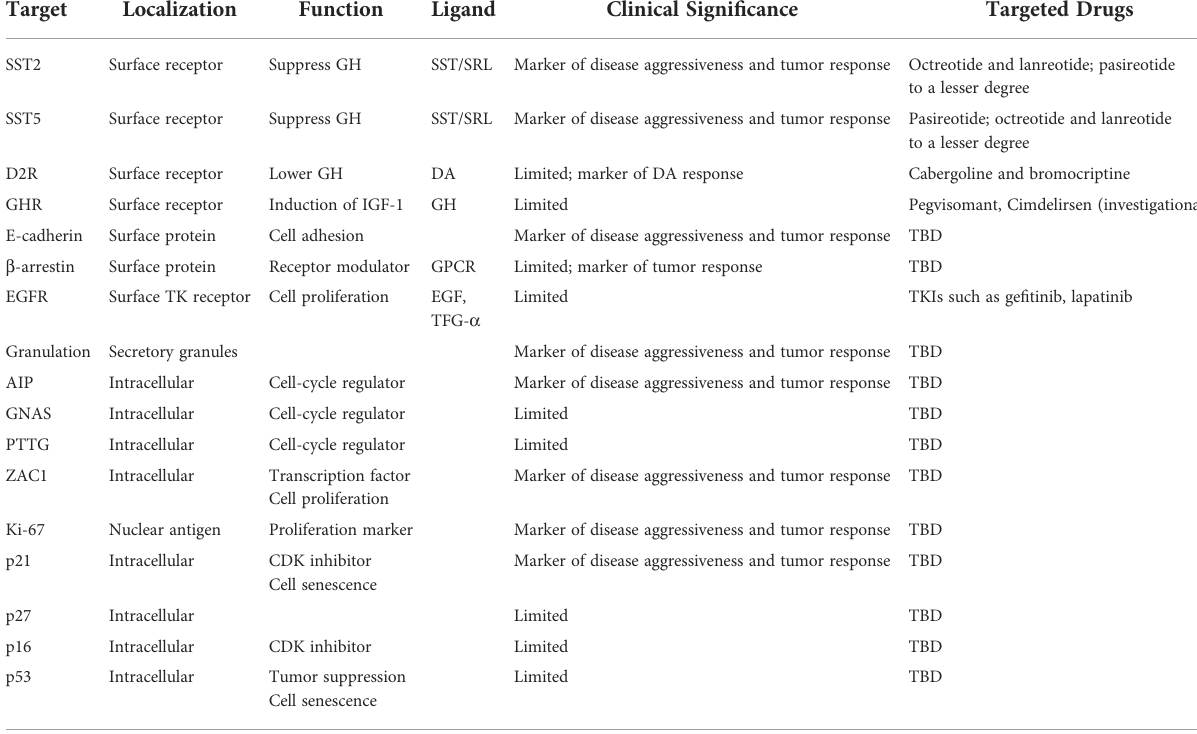
TABLE 1 Molecular targets in